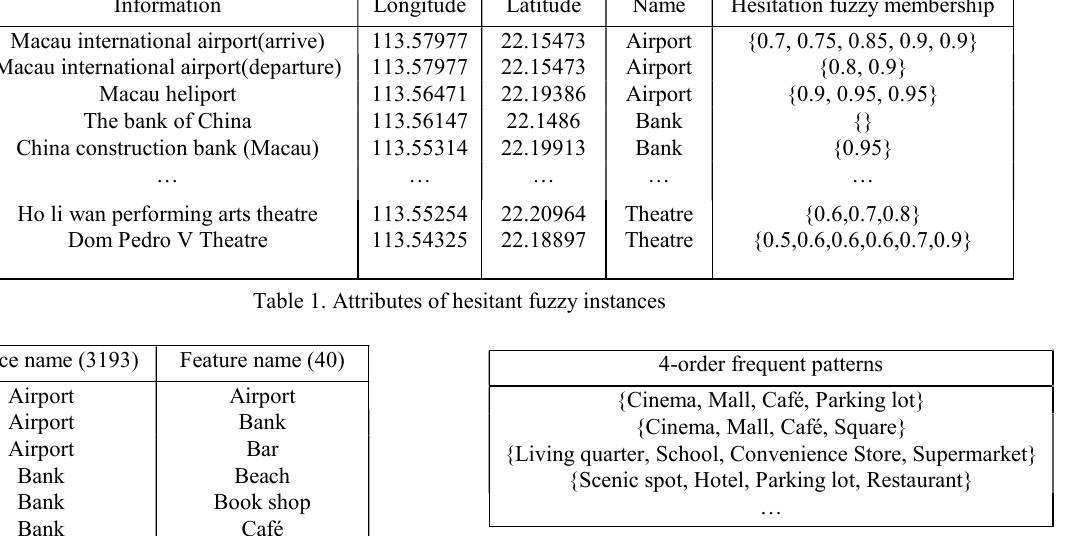
Table 4. 4-order frequent